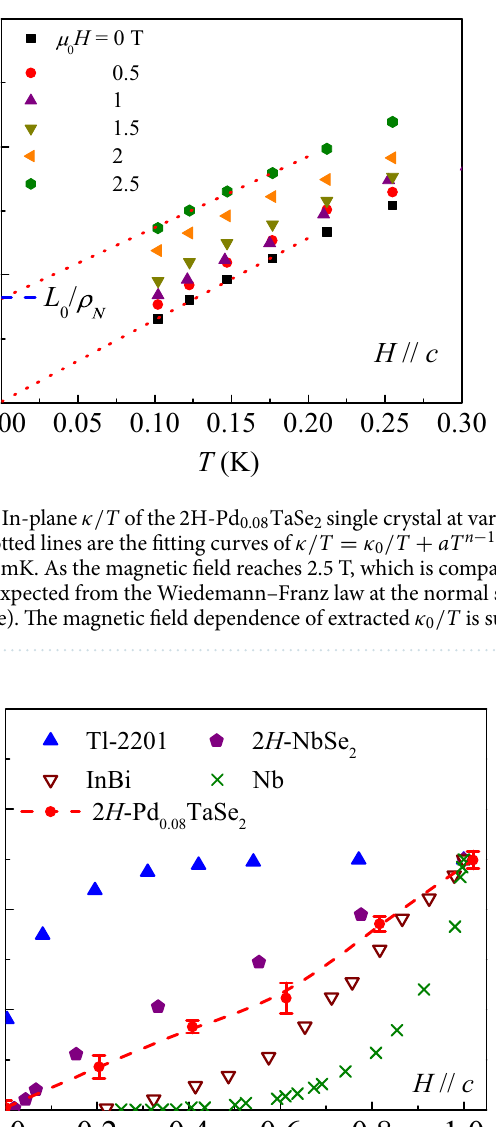
Figure 6. Field dependence of the residual linear term κ 0 ( H )/ T of the 2H-Pd 0.08 TaSe 2 single crystal. The κ 0 ( H )/ T is normalized by the normal-state residual linear term κ N / T = 163 µ W/ K 2 cm and H is normalized by µ 0 H c c ( 0 ) = 2.45 T. The κ N / T is estimated by the Wiedemann–Franz law and the µ 0 H c c ( 0 ) is determined from 2 2 the resistivity measurements (see the text). Error bars correspond to uncertainty in the extrapolation from the κ 0 ( H )/ T / κ N / T power-law fitting. For comparison, of a d -wave superconductor Tl 2 Ba 2 CuO 6 δ (Tl-2201) 54 , [ ] [ ] + a multigap nodeless superconductor 2H-NbSe 2 17 , a dirty nodeless superconductor InBi 50 , and a single nodeless superconductor Nb 46 are plotted